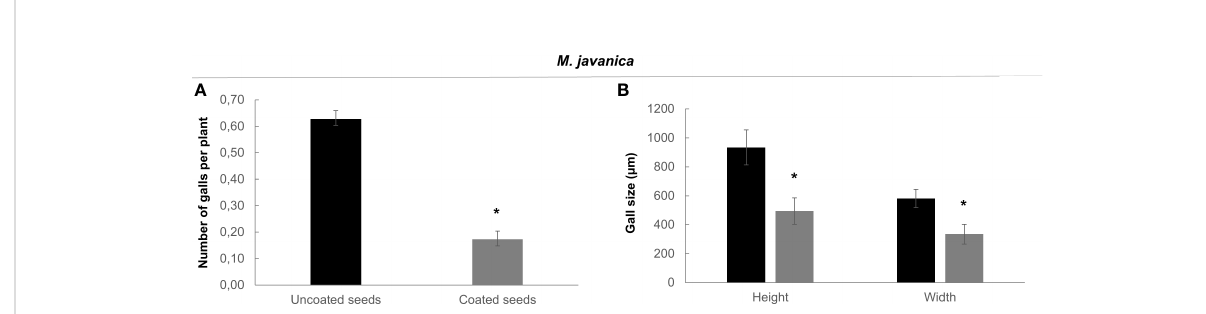
FIGURE 4 Effect of bacterial treatment (coated seeds) in the infection of Solanum lycopersicum (L.) cv. Roma VF with M. javanica . (A) In vitro grown tomato plantlets were evaluated at 4 days post inoculation. Bars represent number of galls per plant ± SE. 140 plants per treatment were tested in three independent experiments. (B) Effect of bacterial treatment in the galls size. Tomato galls were hand-dissected and evaluated 14 days post inoculation. Bars represent mean of galls size (height and width) ± SE for ten galls per treatment from three independent experiments. Seeds were uncoated (black) or coated (grey) with the dual-strain bacteria combination of B paralicheniformis FMCH001 and B subtilis FMCH002. *Asterisks represent signi fi cant differences respect to uncoated seeds (t-test; P<0.05). Black, uncoated seeds, grey, coated